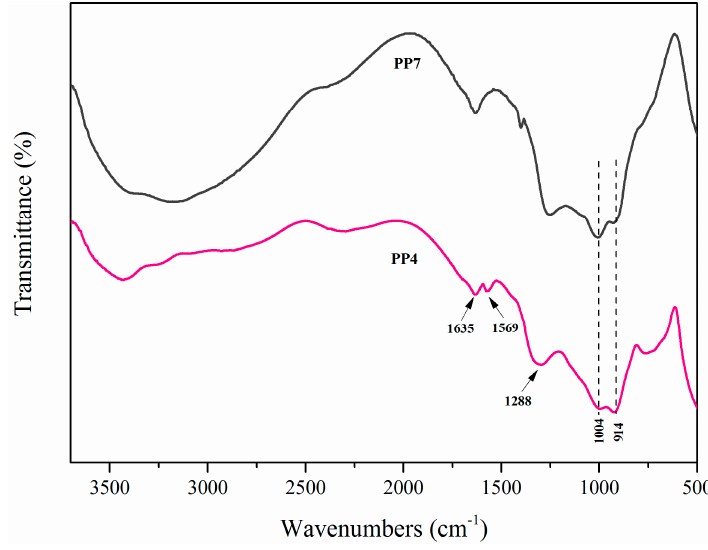
Figure 11. FTIR spectra of PP4 and PP7 residue char.